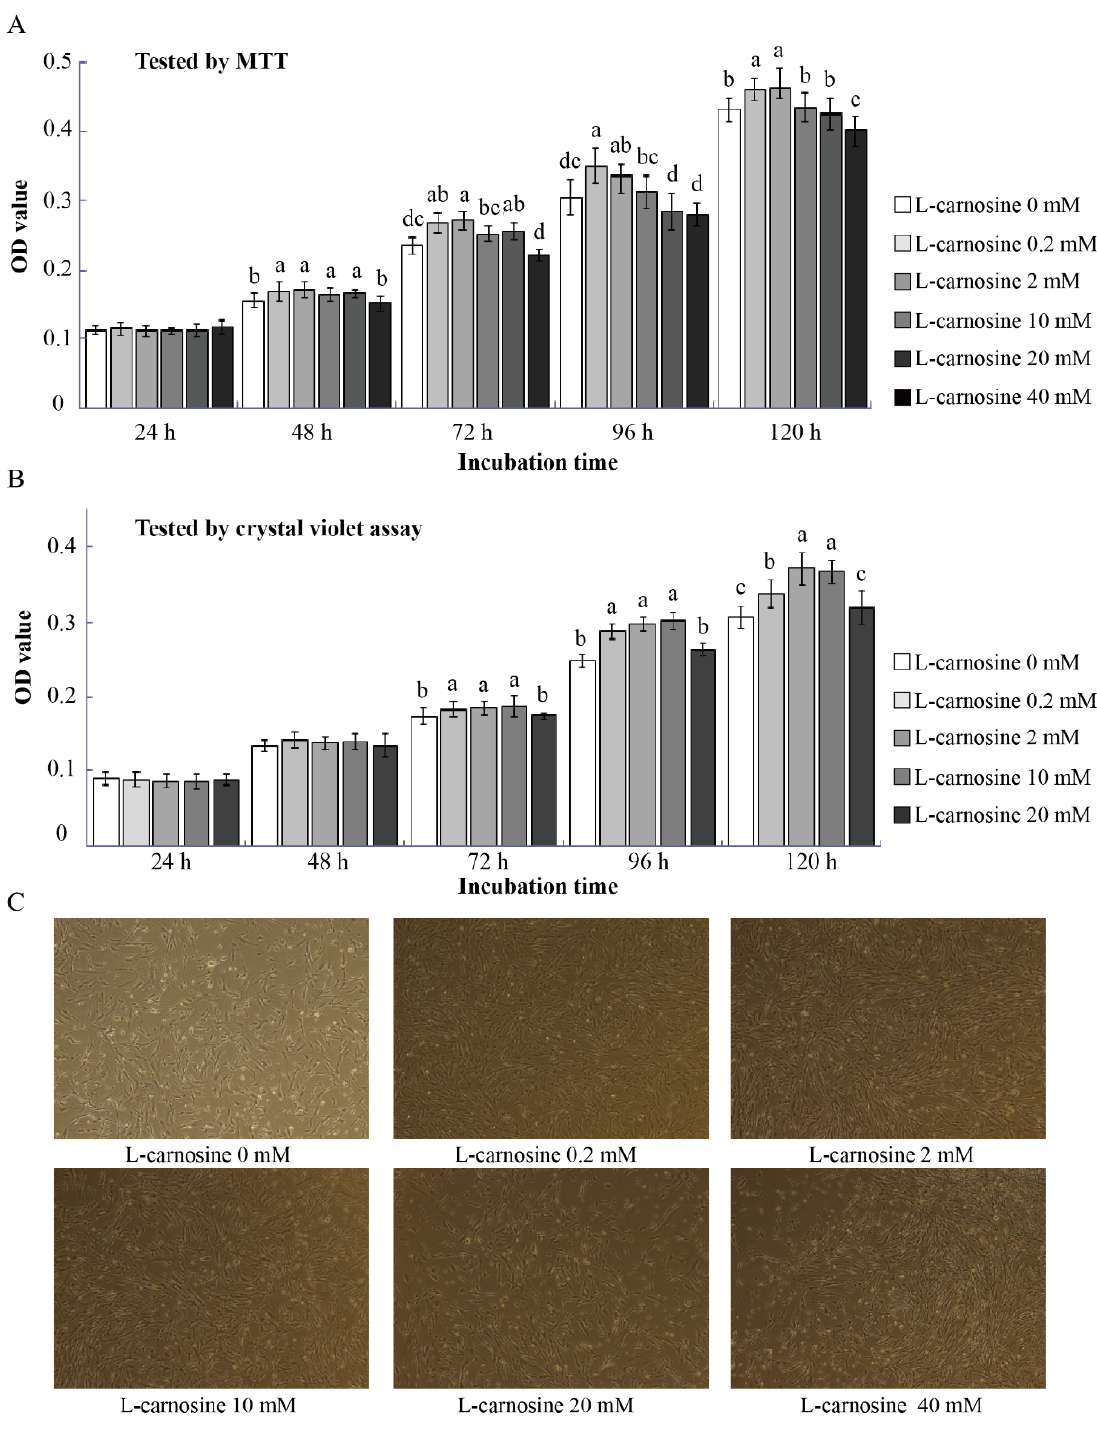
Figure 2. Effect of carnosine on the proliferation of SCs in vitro ( n = 12). The effect of different concentrations of carnosine on cell proliferation ( A , B ); representative images of SCs treated with L-carnosine at 120 h ( C , scale bar = 100 μ m). MTT, 3-(4,5-dimethylthiazol-2-yl)-2,5-diphenyltetrazolium bromide; L-carnosine 0 mM, growth medium without L-carnosine; L-carnosine (0, 0.2, 2, 10, 20 and 40 mM), growth medium supplemented different concentrations of L-carnosine (0, 0.2, 2, 10, 20 and 40 mM). Data are expressed as mean values ± SD. Means with different superscript letters (a–d) indicate significant differences at p < 0.05. Based on these results, concentrations of 0.2, 2, and 20 mM L-carnosine were chosen to assess the effect of L-carnosine or its precursors β -alanine and L-histidine on cell pro- liferation. Both MTT and the crystal violet assay revealed that similar to the results in the pre-test trial (Figure 2B), supplementation of L-carnosine at dosages of 0.2 and 2 mM improved ( p < 0.05) SC proliferation at 72, 96, and 120 h after seeding as compared to the control (Figure 3A,B). Proliferation of SCs exposed to 20 mM was inhibited ( p < 0.05)